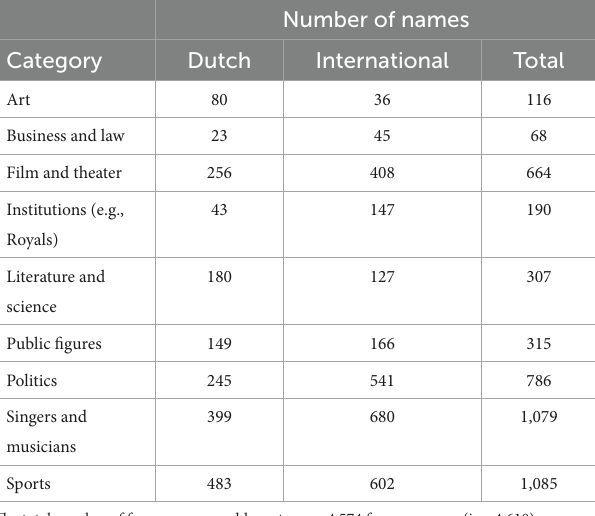
TABLE 2 Overview of categories and the corresponding Dutch and international number of names in step